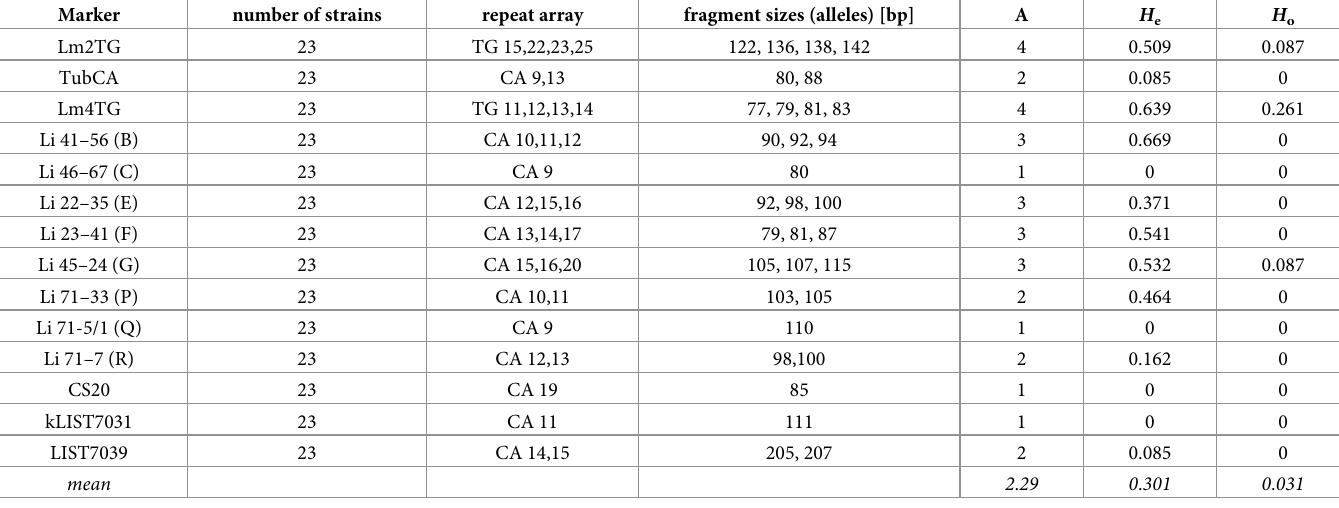
Table 3. Descriptive analysis per locus of the 23 L . infantum samples from Armenia. Marker number of strains repeat array fragment sizes (alleles) [bp]